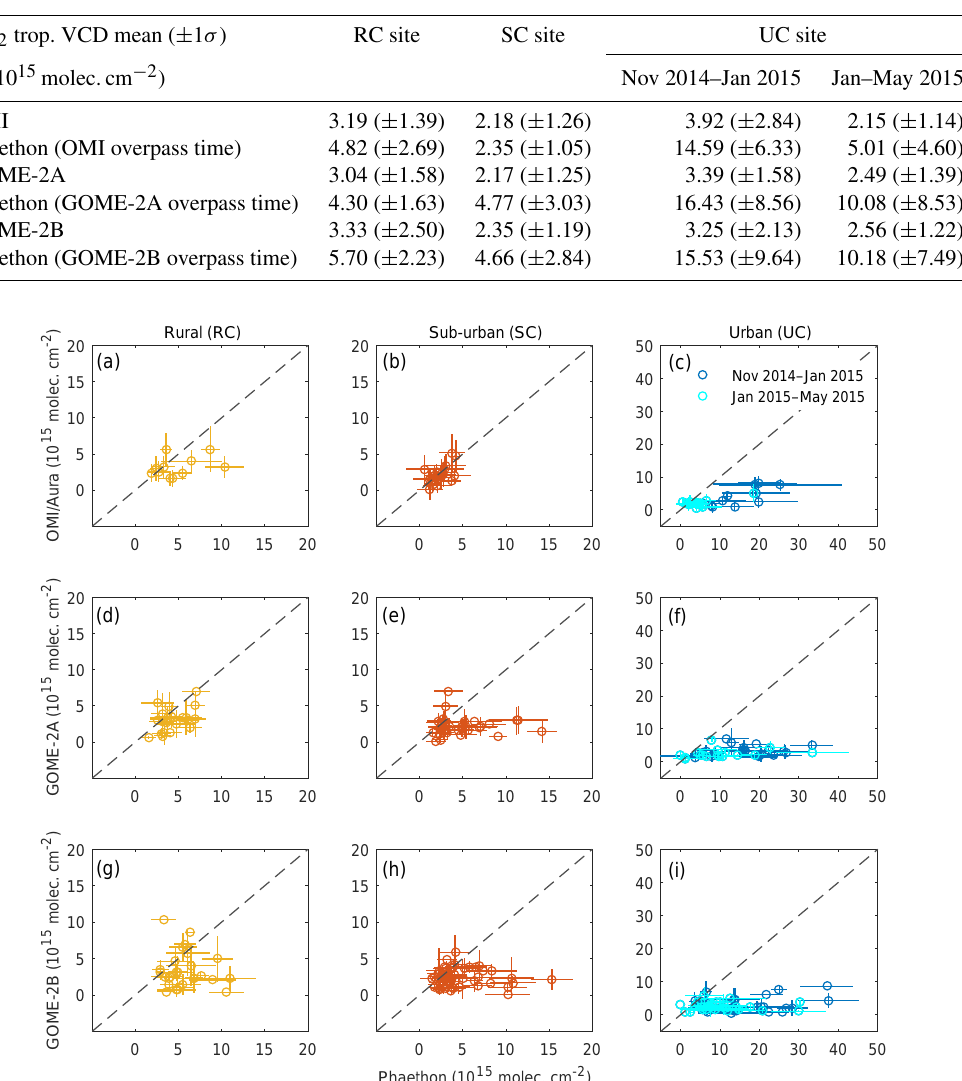
et al. (2008) at Leicester, UK, and Cabauw, the Netherlands, respectively, are about 0.6. In Ialongo et al. (2016), linear fit slopes of 0.49 and 0.39 for V2.1 and V3 OMI retrieval